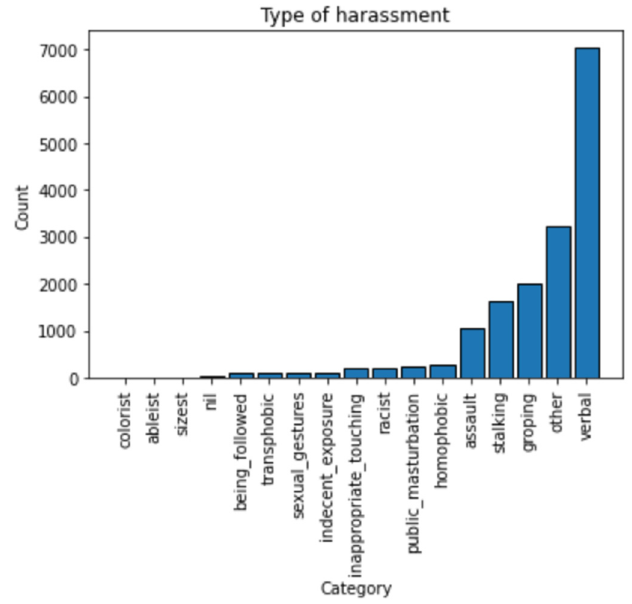
Figure 6. Frequency of type of harassment.